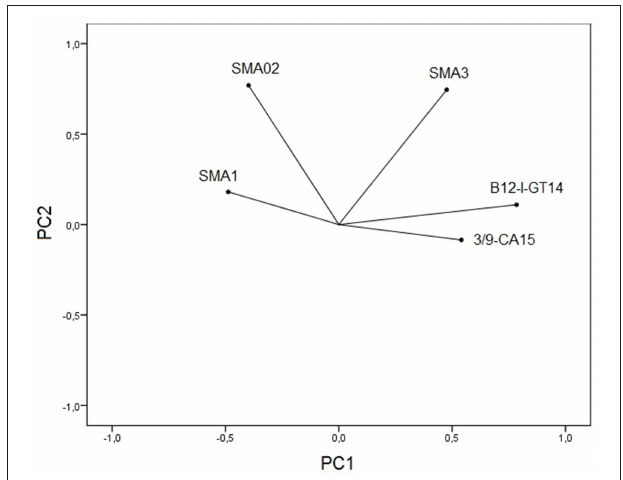
FIGURE 2 | Plotting first two principal component scores shows contribution of five microsatellite loci for population differentiation.